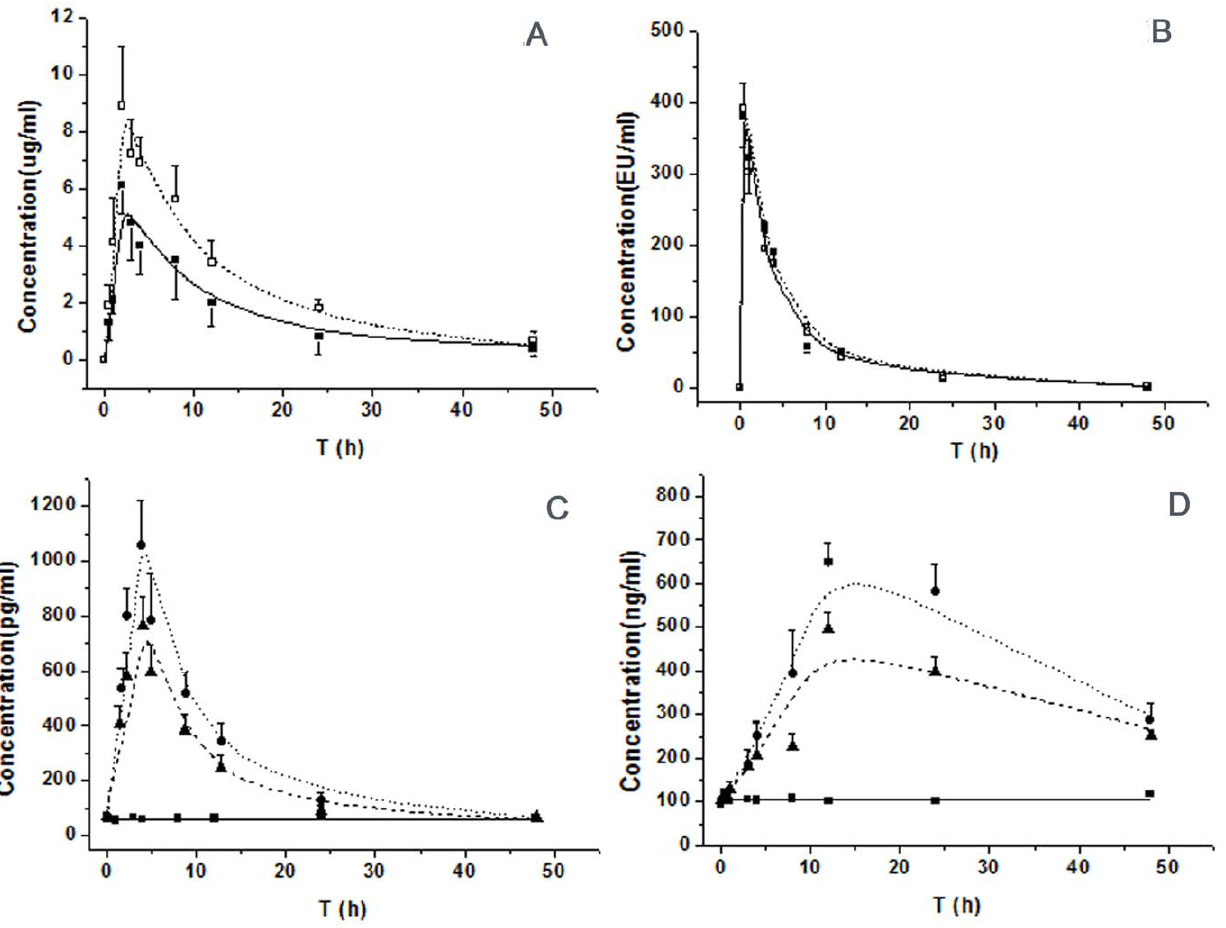
Figure 2. Concentration-time profiles of AZI (A), LPS (B), total PCs (C), and KYN(D) after an i.p. LPS (0.8 mg/kg) and an i.g. AZI (100 mg/kg) in mice. (A): Closed squares and open squares indicated measured values in normal and LPS loading mice, respectively. Model fittings were presented as solid line for the normal mice and dash line for the LPS loading mice, respectively. (B): Closed squares and open squares indicated measured values in normal and AZI-treated mice, respectively. Model fittings were presented as solid line for normal mice and dash line for AZI- treated mice, respectively. (C) and (D): control mice were shown in closed squares and solid line. The model group was shown in closed circles and dot line. The regulative effect of AZI was shown in closed triangle with dash line. All observations were reported as Mean 6 SD (n=8) in Figure 2.